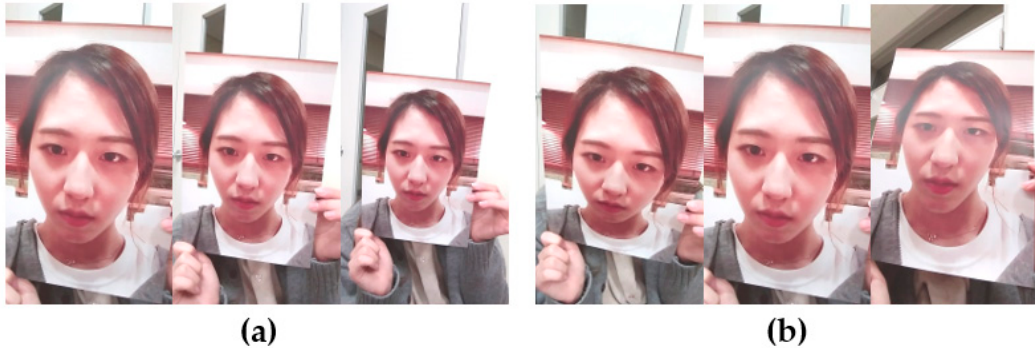
Figure 5. Samples of a printed photo attack: ( a ) three distances (near, halfway, distant); ( b ) three angles (bottom, middle, top).